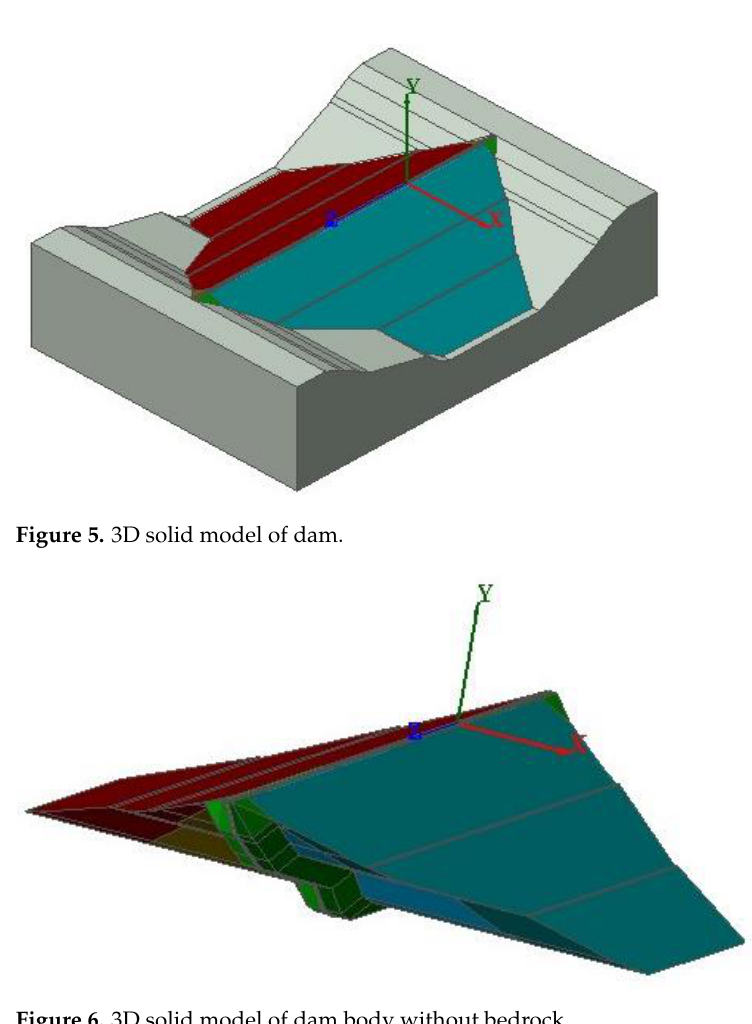
Figure 6. 3D solid model of dam body without bedrock.